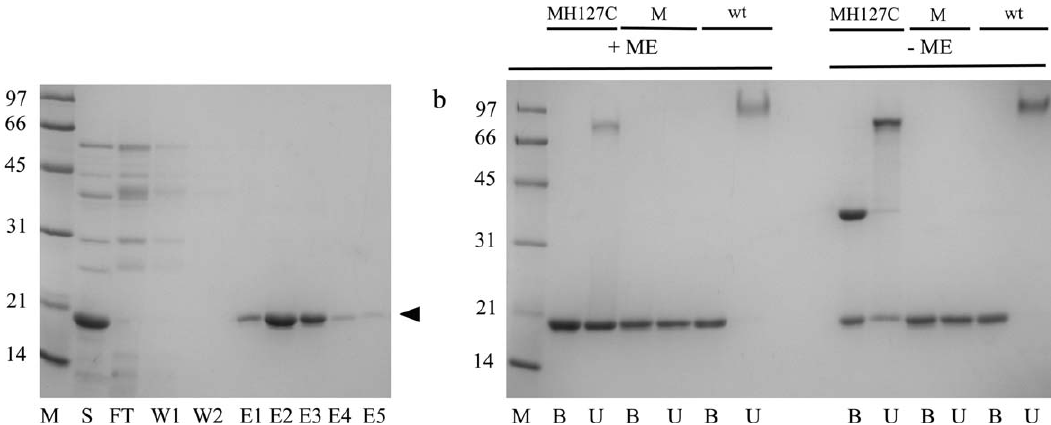
Figure 2. SDS-PAGE showing purification of 8-aa-loop-H127C mutein and its oligomeric state. In panel a, 8-aa-loop-H127C mutein was affinity purified from B. subtilis culture supernatant using biotin-agarose matrix. S represents the concentrated culture supernatant before purification. FT, W and E are the flow-through, wash and elution fractions, respectively. 5 m l from each fraction (800 m l per fraction, each fraction contained the same volume of sample) was reduced with b –mercaptoethanol and boiled before loading onto the gel. The arrowhead marks the position of the 8-aa-loop-H127C mutein. Panel b shows the tetrameric state of 8-aa-loop-H127C (MH127C). 8-aa-loop (M) and wild-type (wt) streptavidin were included as reference. B and U represent the boiled and unboiled samples respectively. ME represents b –mercaptoethanol (used at